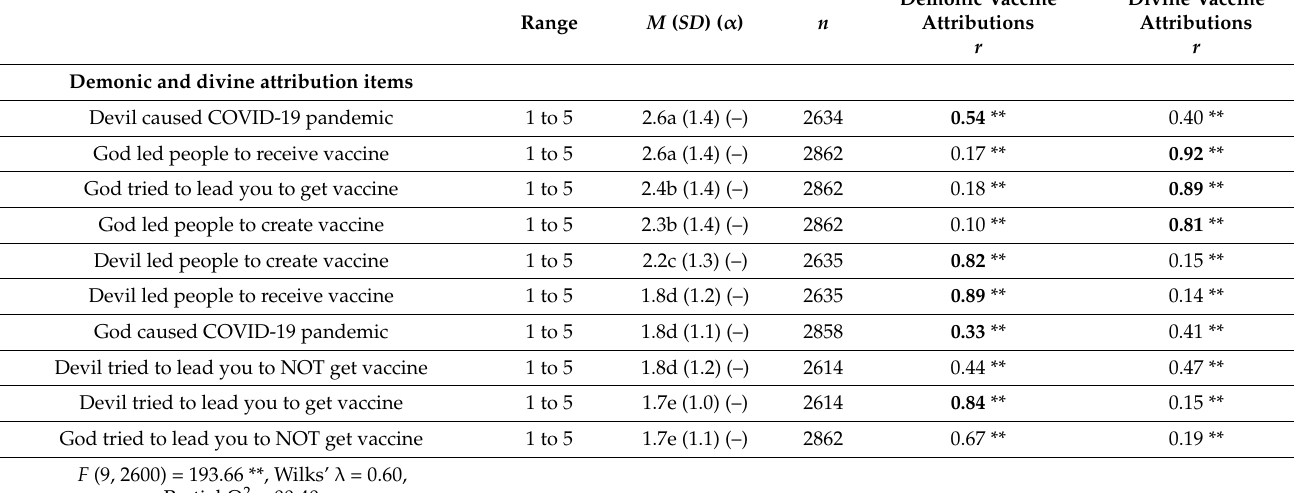
Table 1. Variables Related to COVID-19 and Vaccines: Descriptive Statistics and Correlations with Demonic and Divine Vaccine